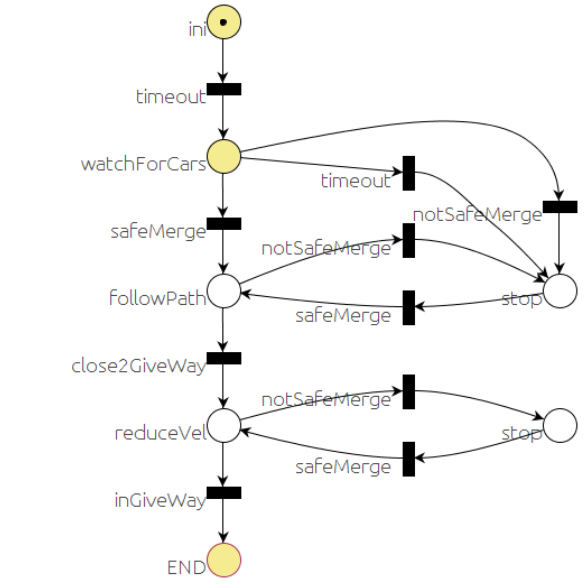
Figure 17. Yield behavior